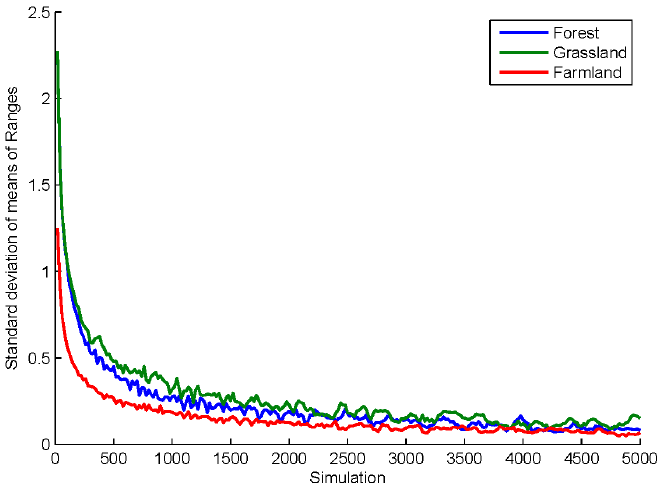
Figure 9. Relationship between the simulation times and standard deviation of average fitting ranges for forest ( blue ), grassland ( green ), and farmland ( red ) in Ansai County.